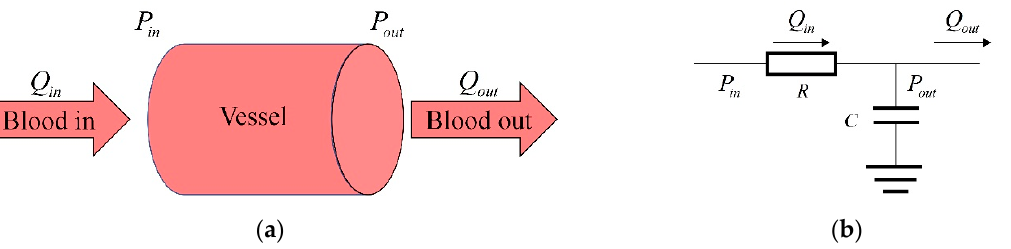
Figure 6. Vessel and its corresponding circuit: ( a ) vessel physiological model, ( b ) vessel corresponding circuit.